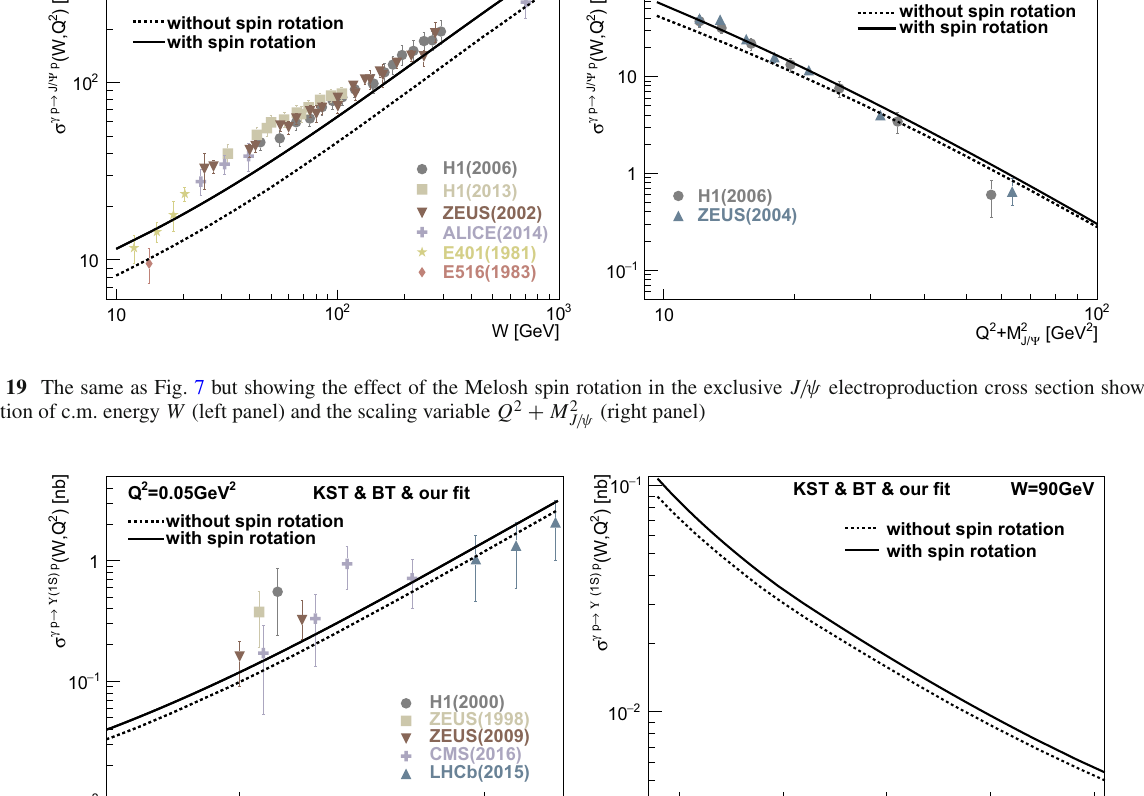
Fig. 20 The same as Figs. 8 and 19 but for exclusive electroproduction of ϒ( 1 S ) bottomonium